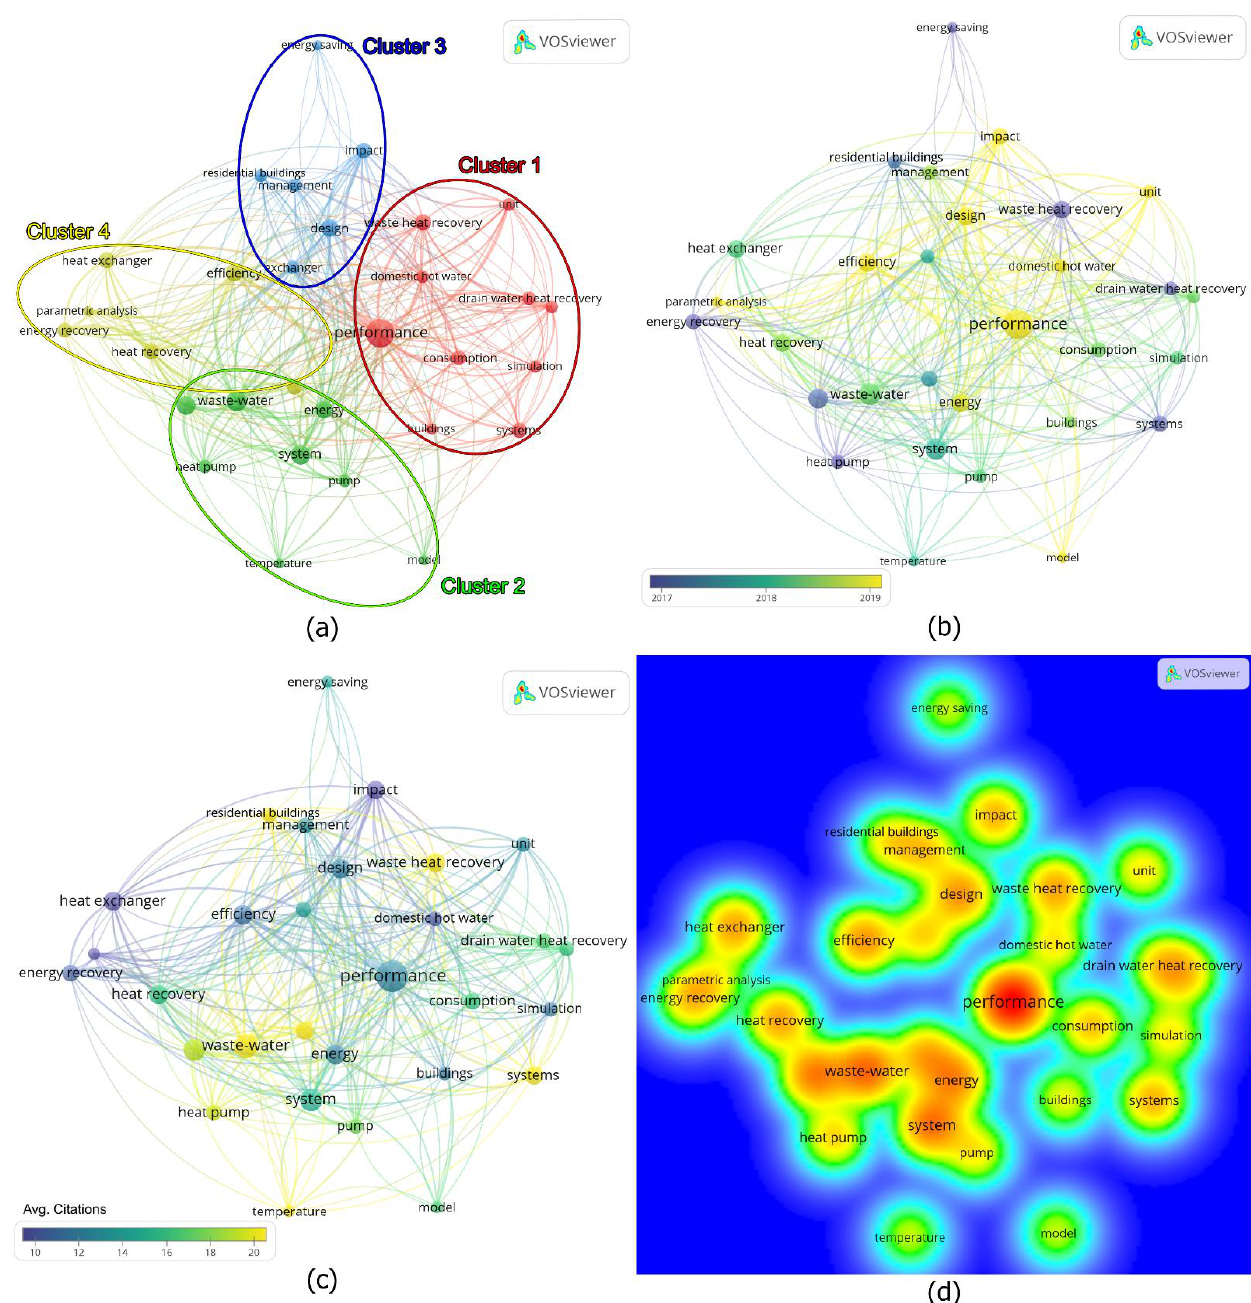
Figure 3. The keywords co-occurrence network of greywater energy recovery papers: ( a ) Clusters distributions; ( b ) Timeline of occurrences, ( c ) Average number of citations; ( d ) Density view.